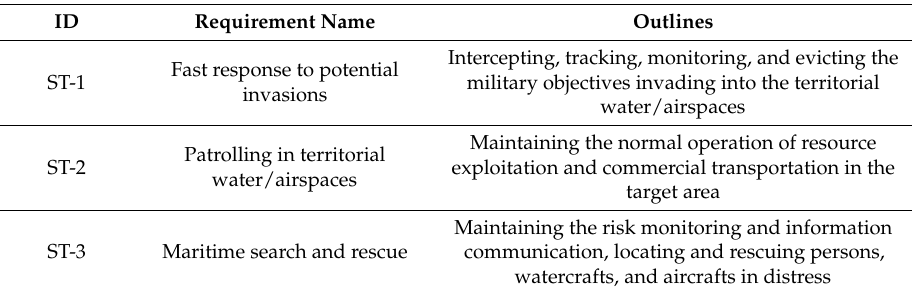
Table 2. Requirement elements at the strategy level.